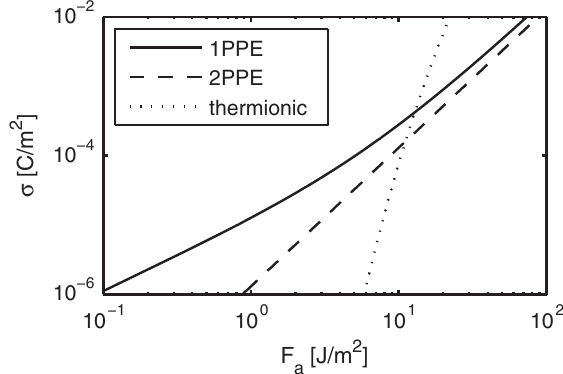
FIG. 1. One-photon photoemission (1PPE) and two-photon photoemission (2PPE) compared with thermionic emission as a function of absorbed fluence.